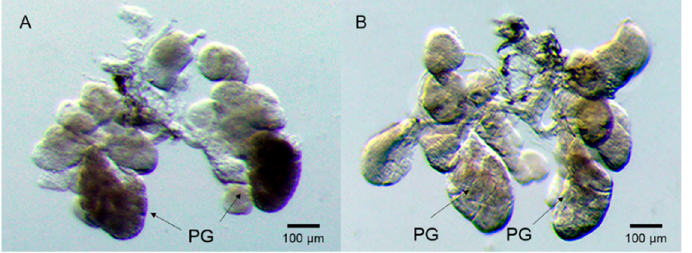
Figure 5. Effects of SFMLP knockdown on the morphology of the salivary gland of WBPH. ( A ) WBPH injected with dsGFP ; ( B ) WBPH injected with dsSFMLP . PG indicates the principal gland. The arrow indicates the A-follicle of the principal gland.